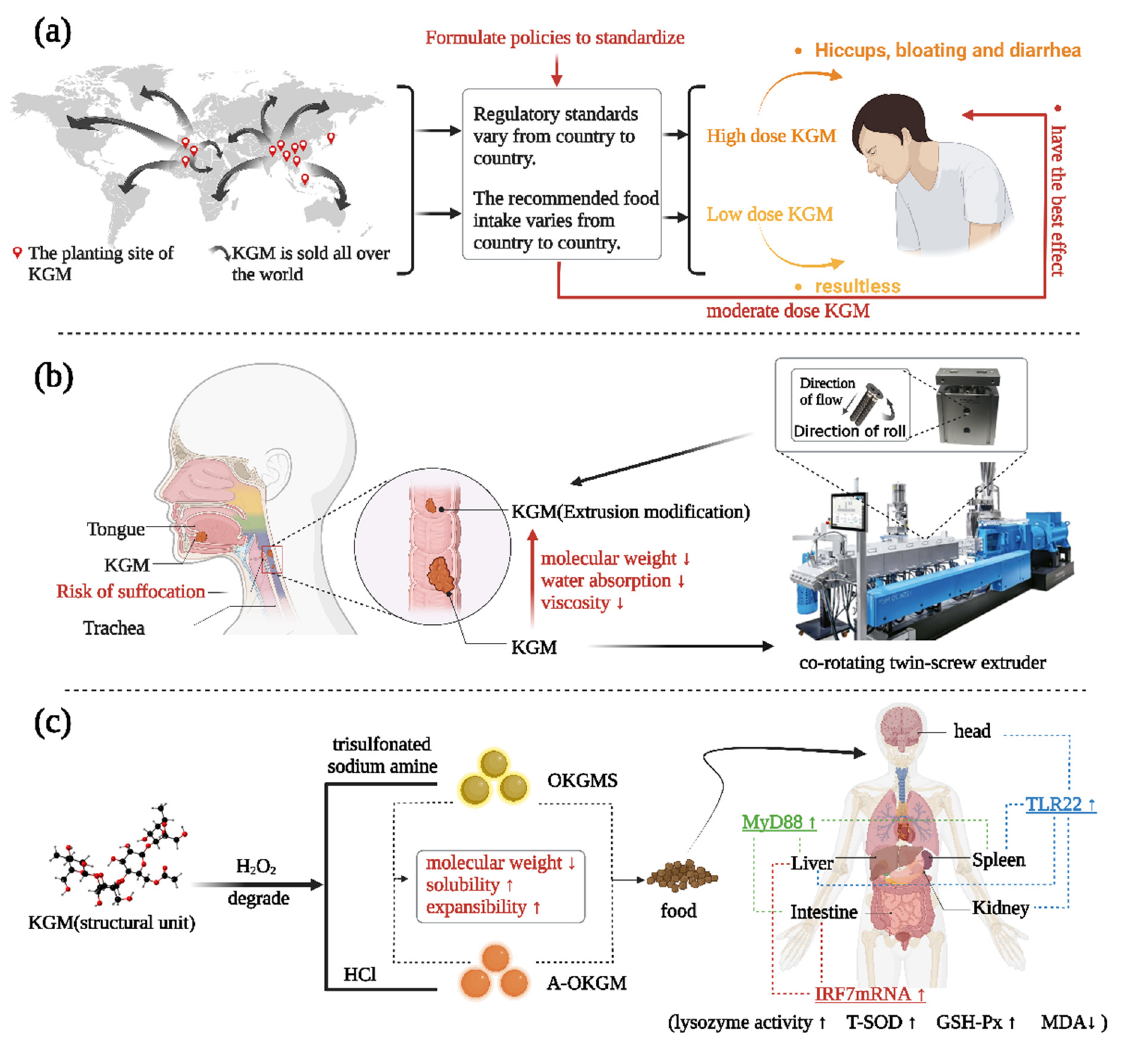
Figure 7. Some solutions to KGM’s problems. ( a ) The establishment of a unified regulatory system can better regulate the average daily intake of KGM and reduce the side effects. ( b ) KGM that has undergone physical modification can lessen the asphyxia risk. ( c ) Chemically altered KGM derivatives can improve the body’s immunological indicators.